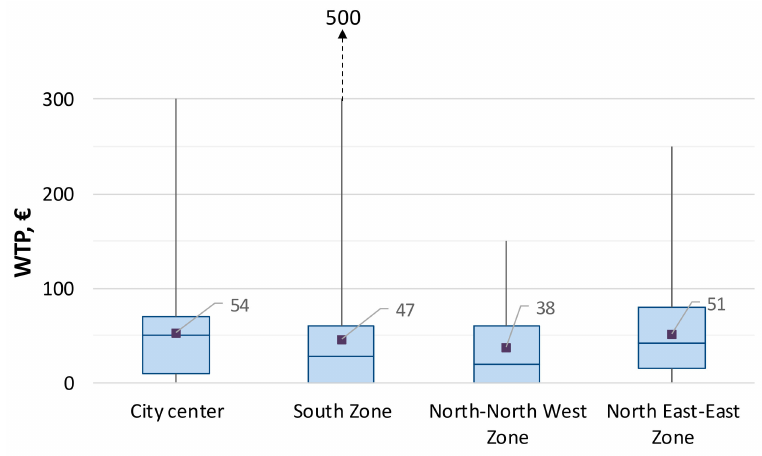
Figure 9. Distribution of WTP with respect to the resident